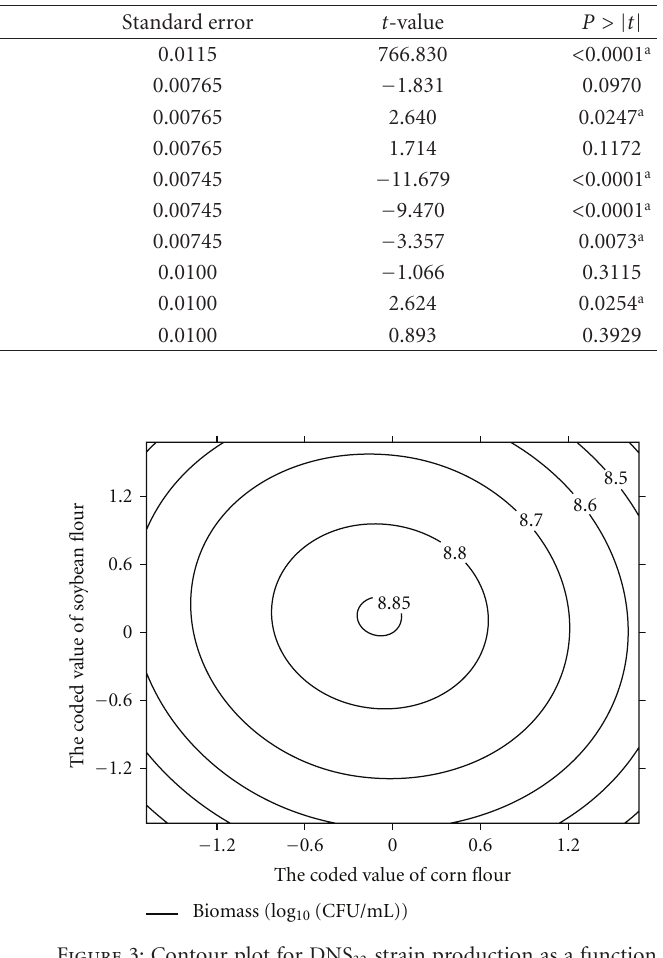
Figure 2: Observed responses predicted responses under the central composite design.